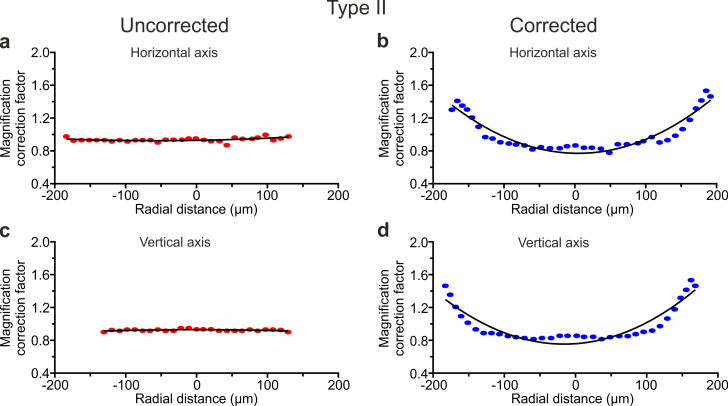
Field curvature in eFOV-microendoscopes.(a,b) Magnification correction factor in the horizontal direction as a function of the radial position in uncorrected (a) and corrected (b) type II eFOV-microendoscopes. Plots show values obtained from one representative measurement. Dots represent experimental data. Black lines indicate quadratic polynomial fit. (c,d) Same as in (a,b) for the vertical direction.Figure 3—figure supplement 4—source data 1.Magnification correction factor as a function of the radial position in uncorrected and corrected type II microendoscopes.